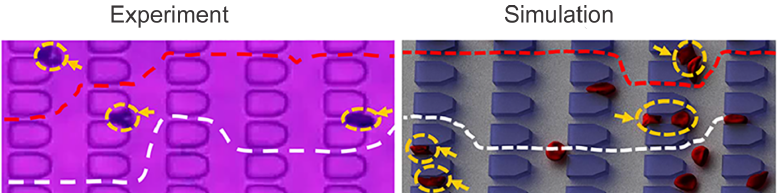
Figure 3. ( Left ) Microfluidics device showing individual SS-RBC passage through capillary-inspired microchannels under transient hypoxia. ( Right ) The corresponding simulations of SS-RBCs passage through capillary-like microchannels under transient hypoxia by dissipative particle dynamics. Reproduced with permission from reference